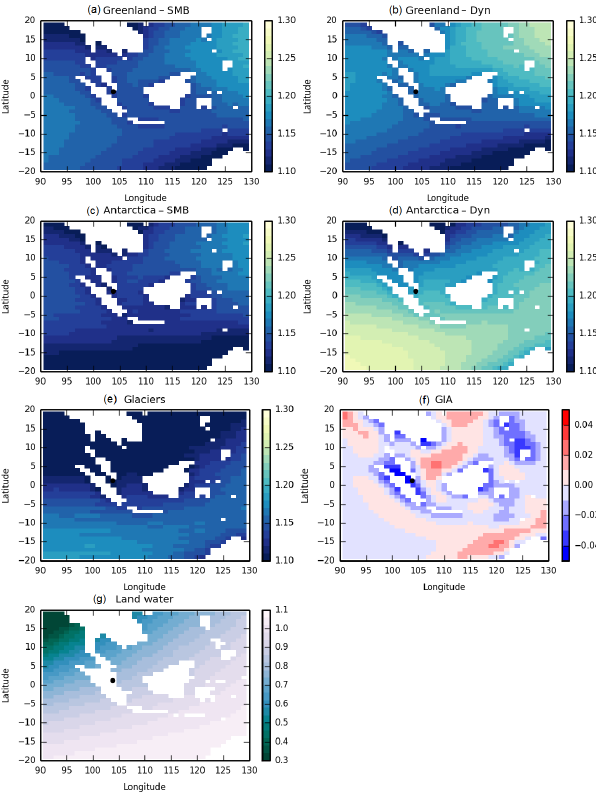
Figure 2. Spatial fingerprints for changes in (a) Greenland surface mass balance, (b) Greenland dynamical change, (c) Antarctica sur- face mass balance, (d) Antarctica dynamical change, (e) glaciers, (f) glacial isostatic adjustment and (g) changes in land water use. Panels (a) – (e) represent the ratio of local relative sea level change per unit of GMSL rise associated with mass input to the oceans. The location of Singapore is shown by the black circle. Source: Slangen et al.